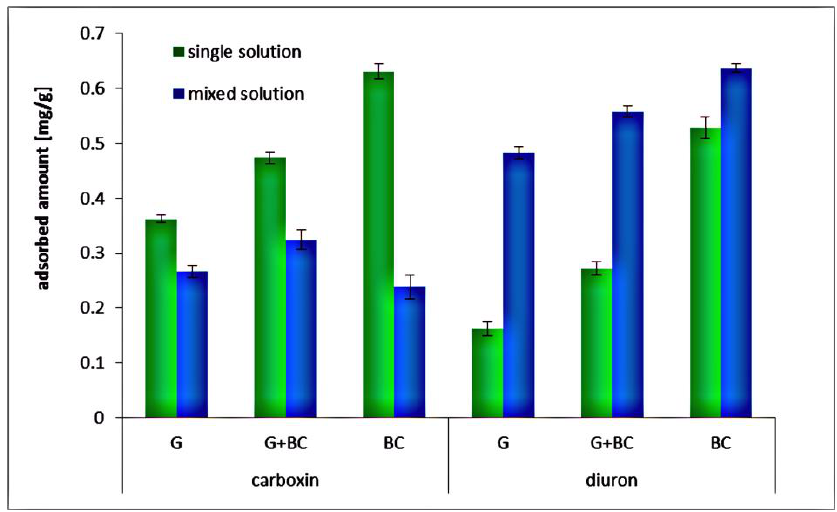
Figure 7. Adsorbed amount of diuron and carboxin on goethite, biochar and goethite–biochar mixture in the mixed pesticide solutions, at pH 5.